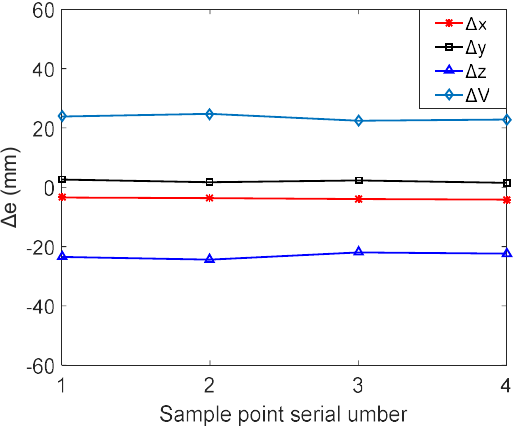
Figure 11. The position errors of the each optimal position before calibration. Table 6. The Error distribution area of the end-effector before calibration.